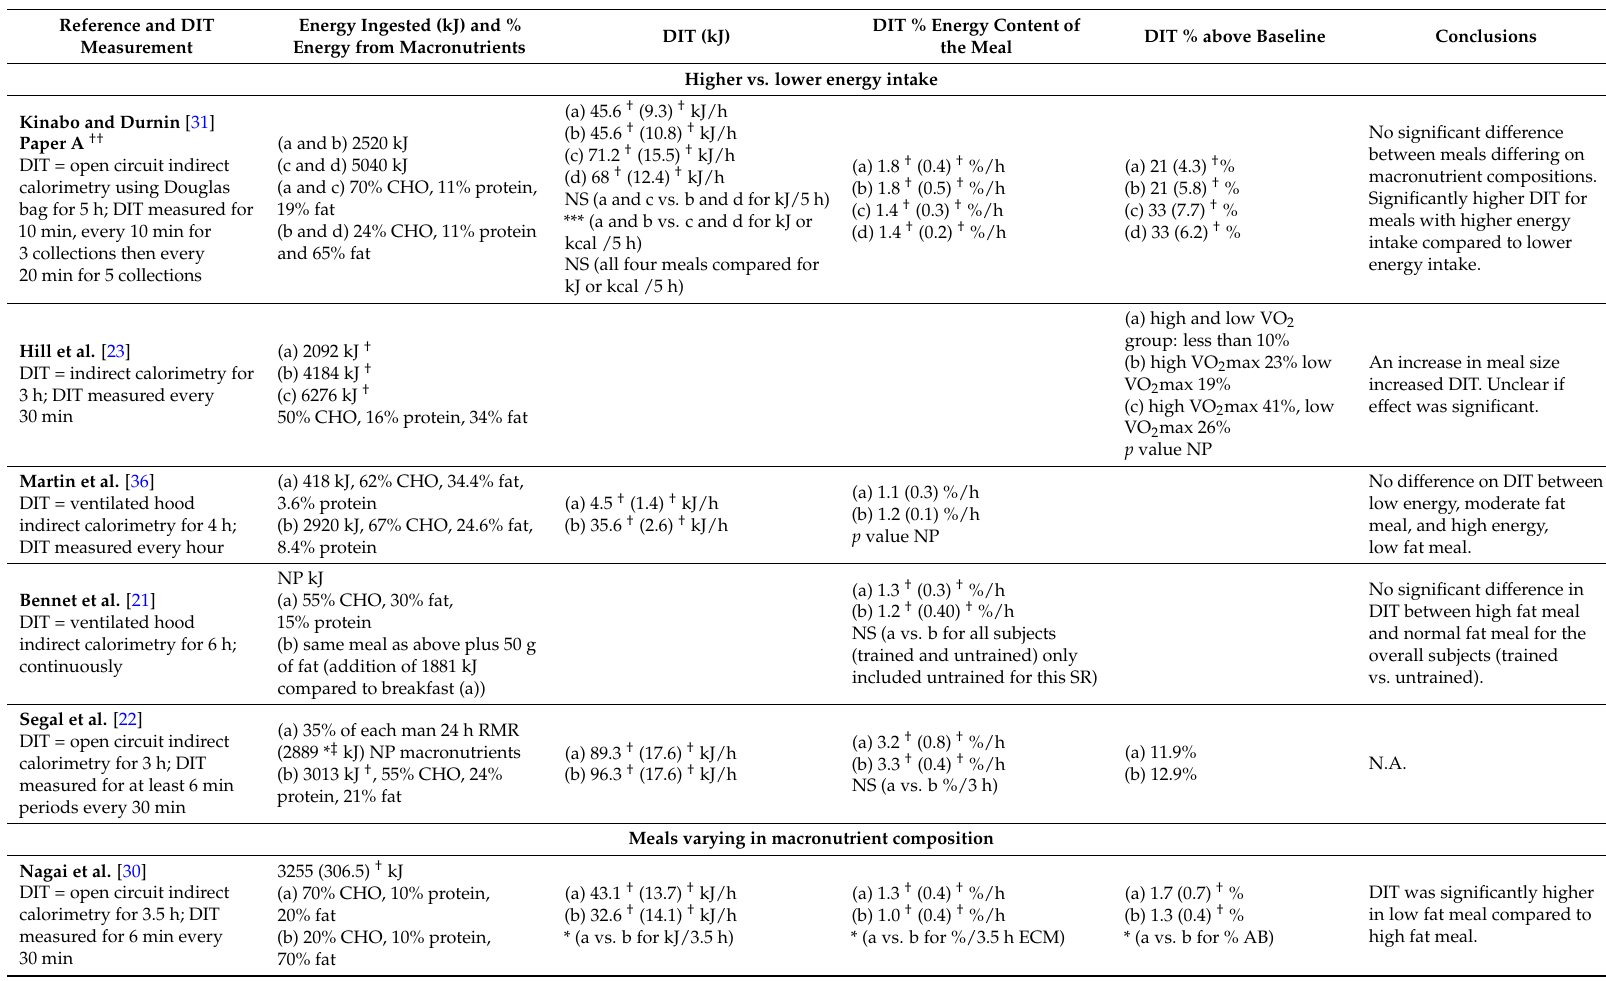
Table 2. Consumption of meals after an overnight fast and